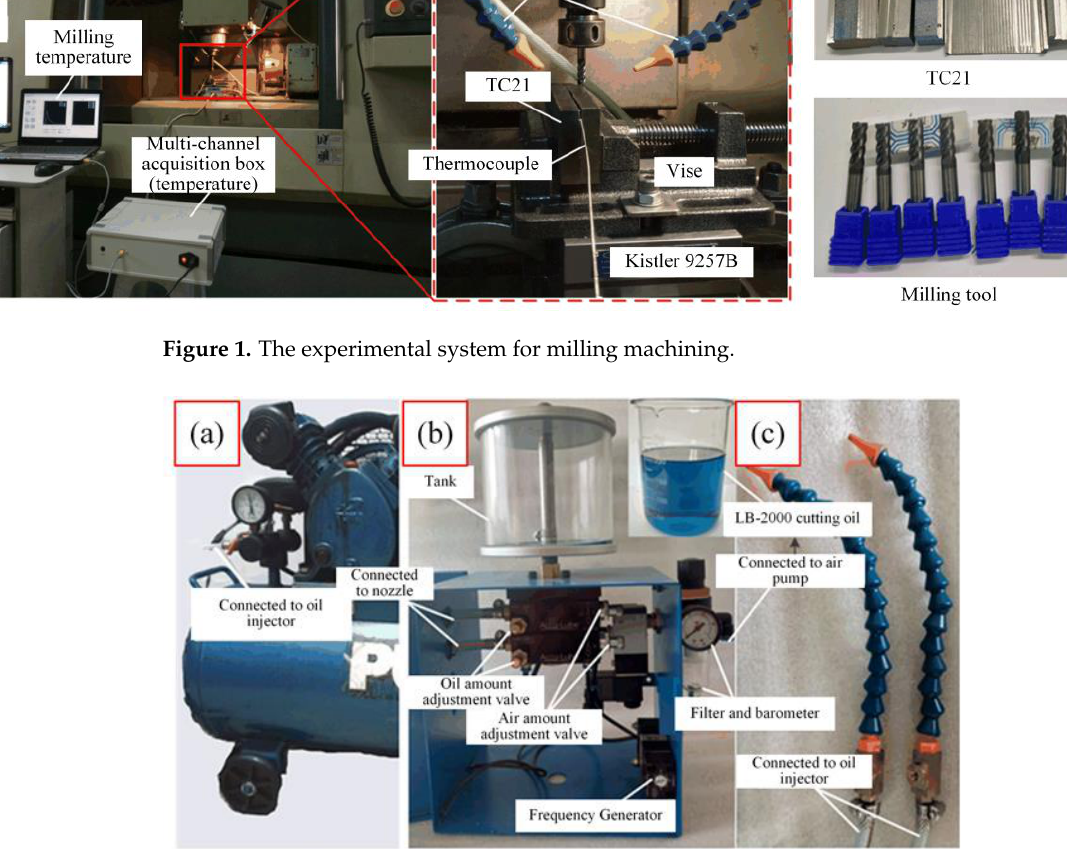
Figure 1. The experimental system for milling machining.